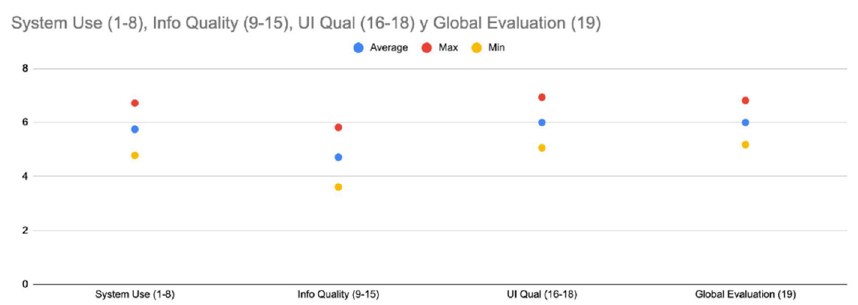
Figure 10. Evaluation of the System User Usability